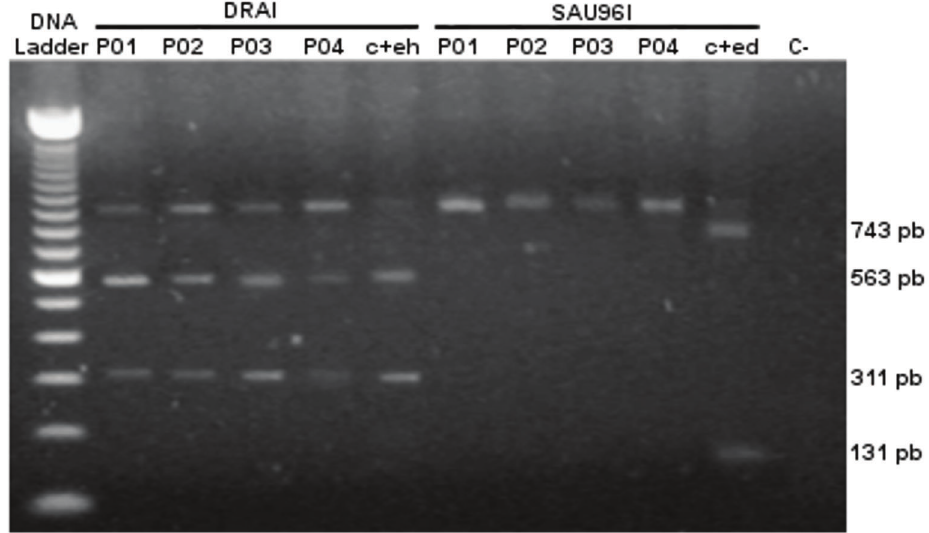
Figure 4. Nested PCR-RFLP (restriction fragment length polymorphism) of SSU rRNA gene for the identi fi cation of E . histolytica and E. dispar . Lane 1 , molecular weight marker; lanes 2 – 5 , Dra I digested PCR products; lane 6 , DNA positive control for E. histo- lytica (c + eh); lane 7 – 10 , Sau 96I digested PCR products; lane 11 , DNA positive control for E. dispar (c + ed); and lane 12 , negative